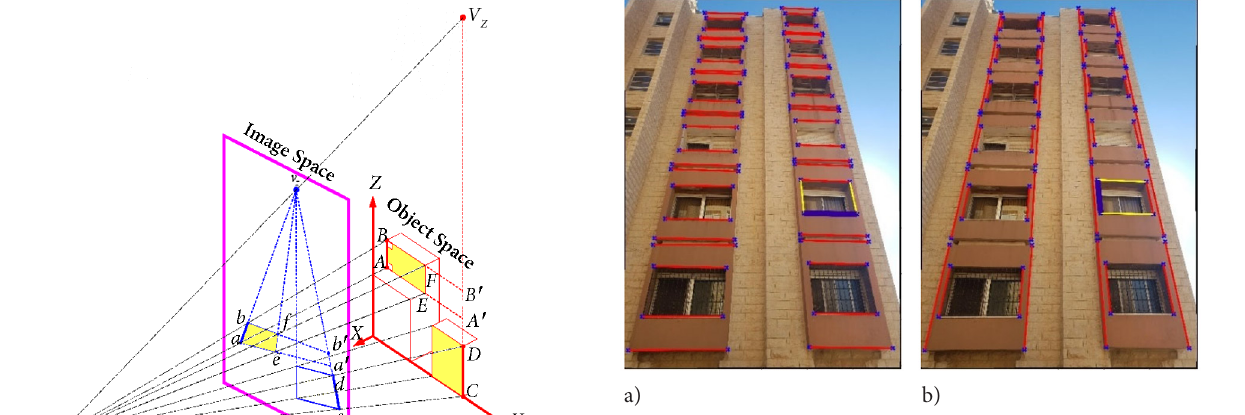
Figure 9. Image lines: a – image lines for horizontal object lines; b – image lines for vertical object